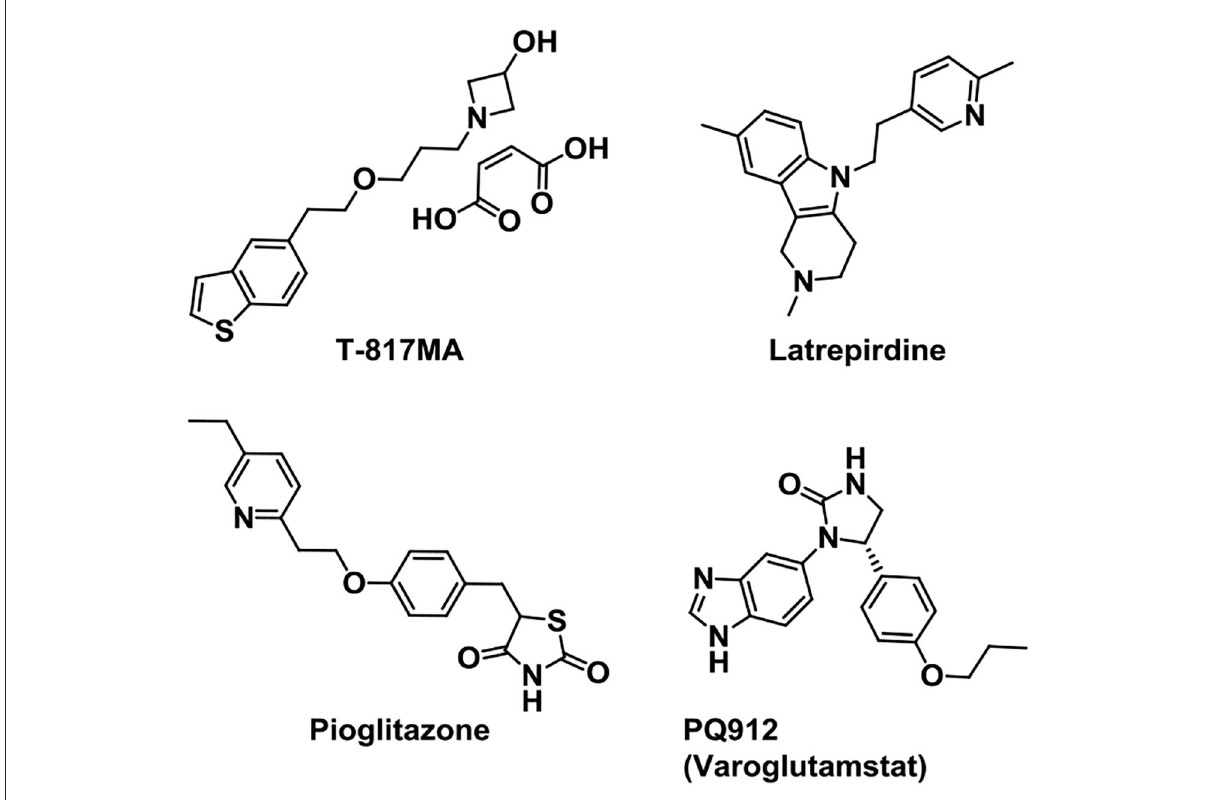
FIGURE10 Structures of other targeted